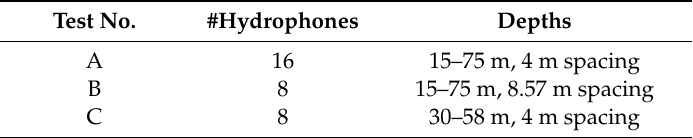
Table 3. Simulated array configurations with di ff erent hydrophones and spacing. Test No.